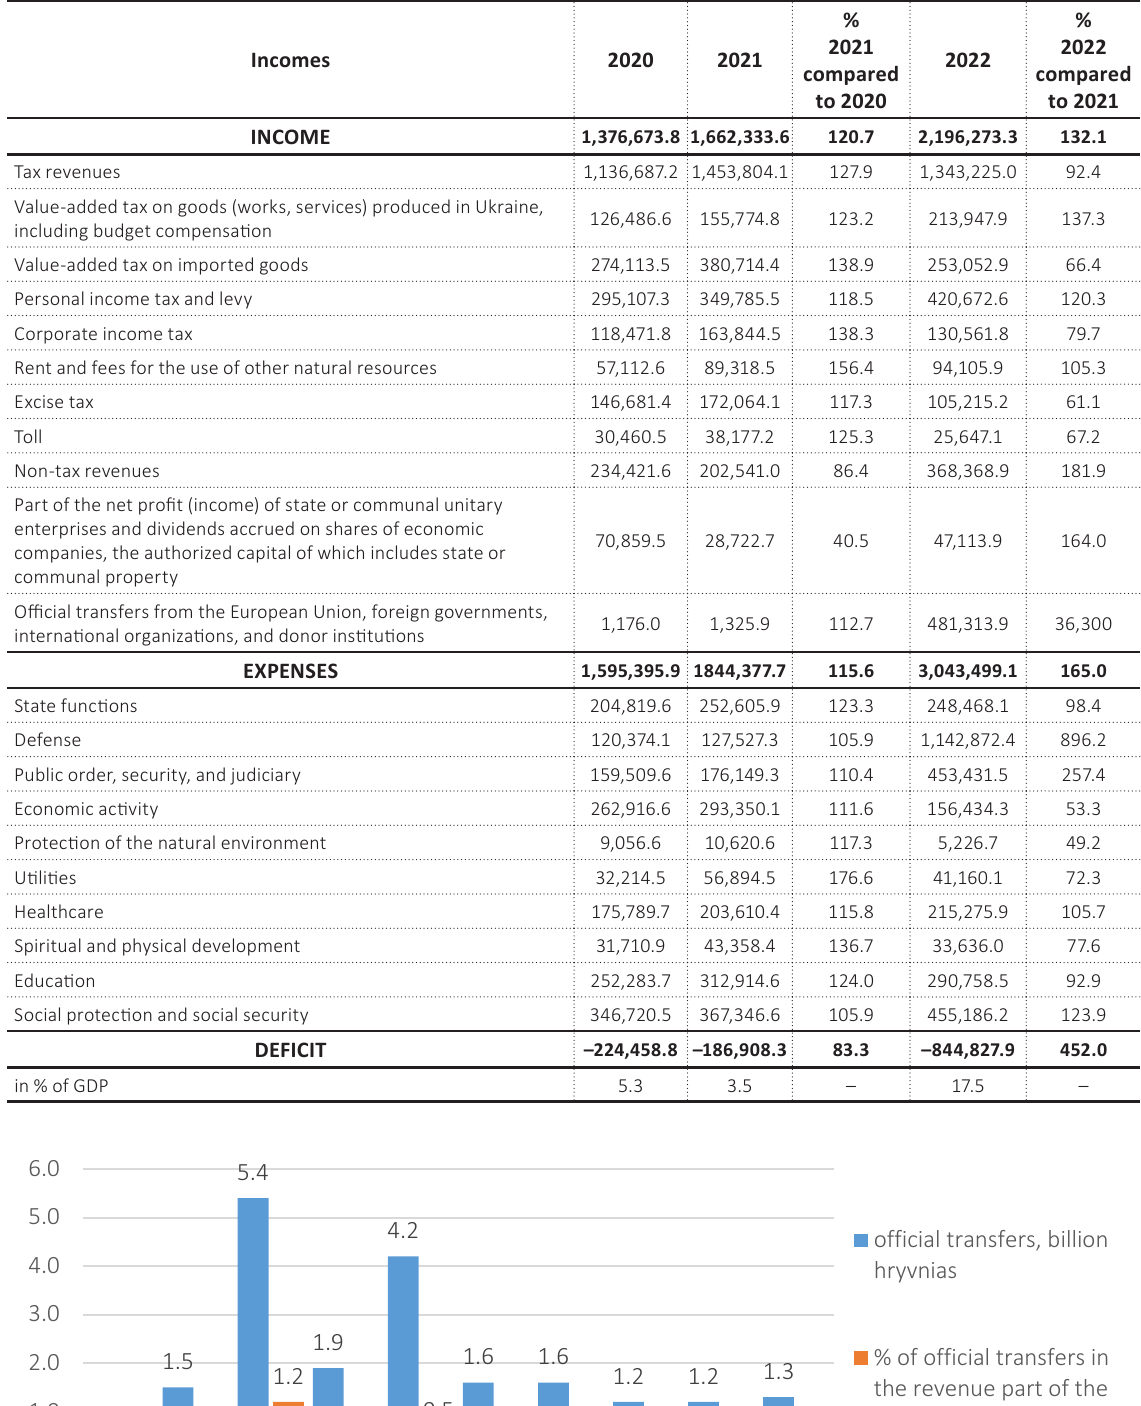
Table 1. Indicators of the Consolidated Budget of Ukraine, million UAH Source: Based on the data from the Ministry of Finance of Ukraine (2022).